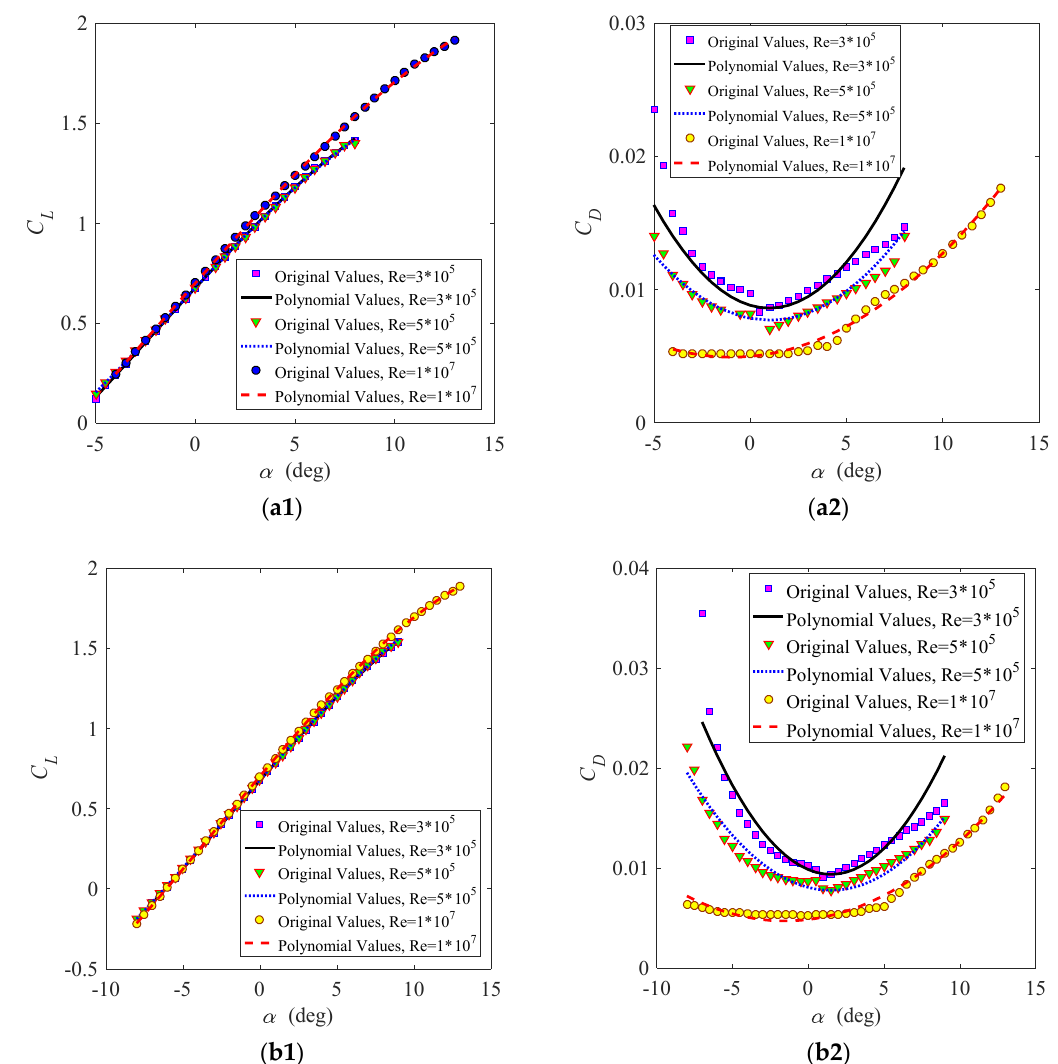
Figure 8. Comparison of original and polynomial values of C L and C D curves for asymmetric airfoils: ( a1 , a2 ) the NACA6409 airfoil; and ( b1 , b2 ) the NACA6411 airfoil.